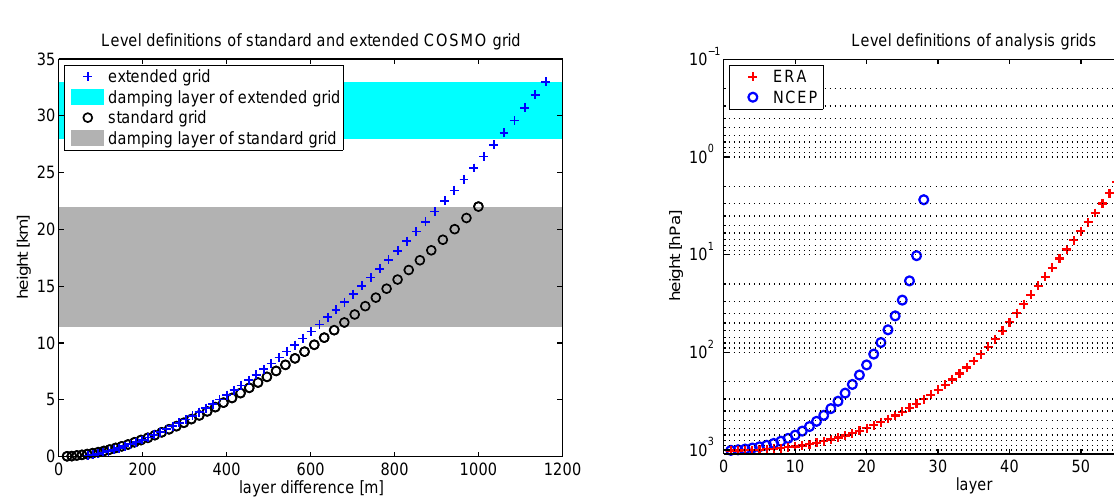
Figure 1. The vertical grids of the COSMO model considered in this study. The damping layers are also given as shaded areas.